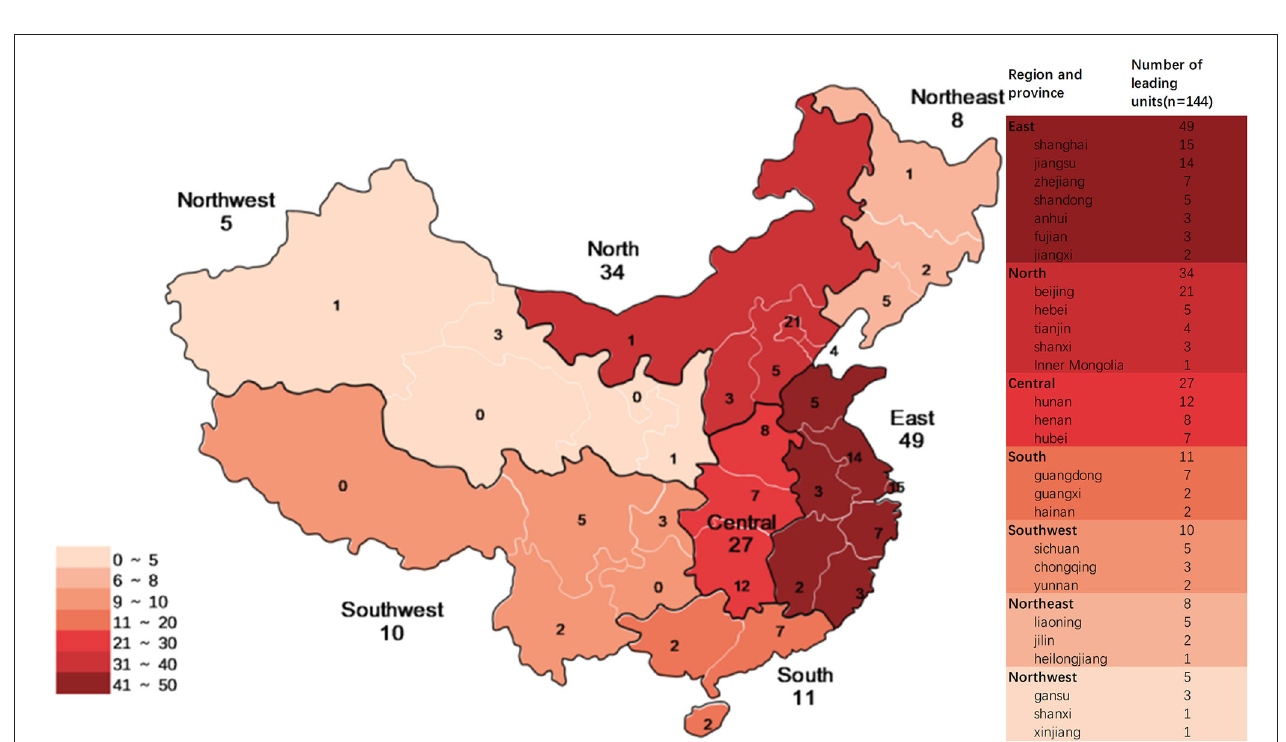
FIGURE 10 | Distribution of leading unit institutions in mainland China.